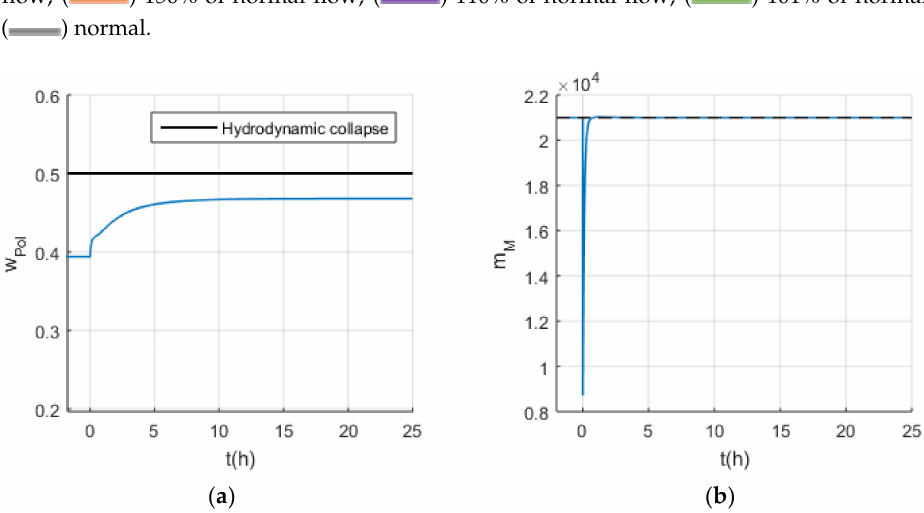
Figure 30. ( a ) Effect of the polymer fraction behavior for τ c = 0.1; ( b ) effect of the monomer inlet mass rate, m M , for τ c = 0.1 with Model 1. Purge mass flowrate: ( ) maximum